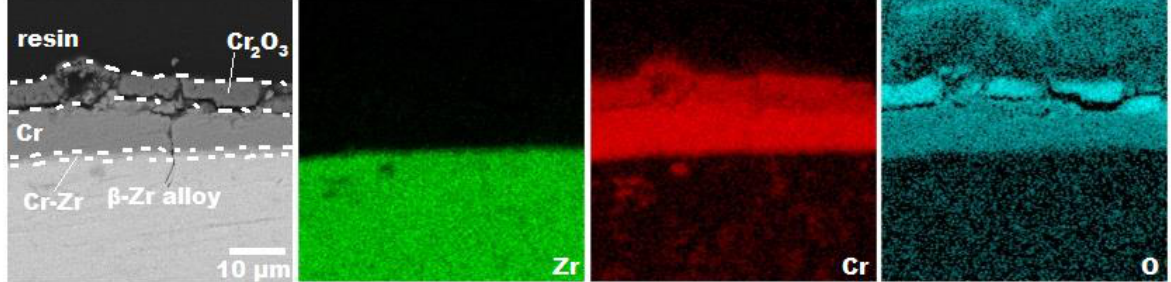
Figure 6. Cross-section SEM image of the Cr-coated LBW E110 alloy sample after 45 min oxidation and corresponding EDS maps of Zr, Cr, and O.